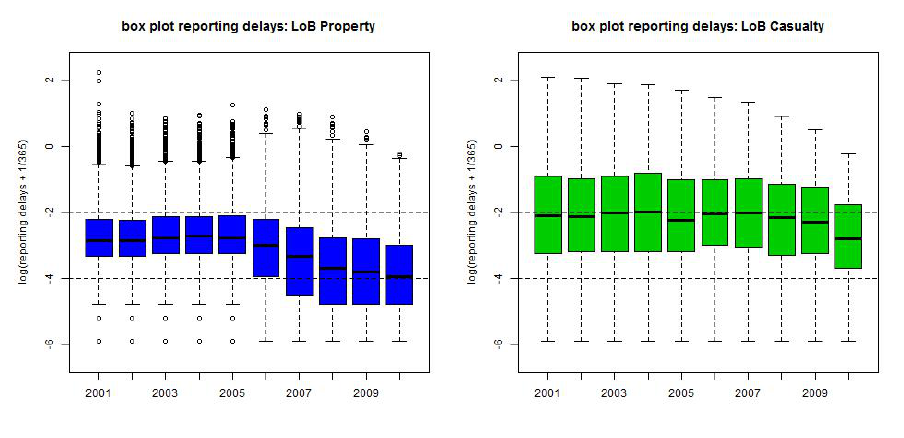
Figure 3. Box plots of the logged reporting delays log ( U (cid:96) ) on the yearly scale (lhs) LoB Property, (rhs) LoB